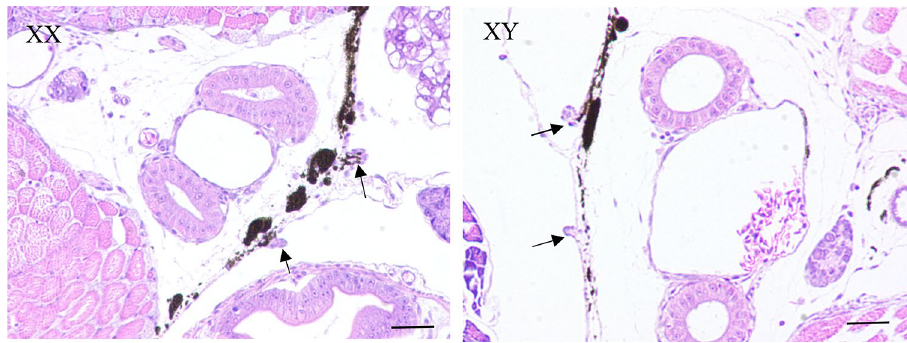
Figure 1. Hematoxylin–eosin stained sections of T. rubripes gonads from 40 days after hatching. Scale bars, 100 μm. Arrow,